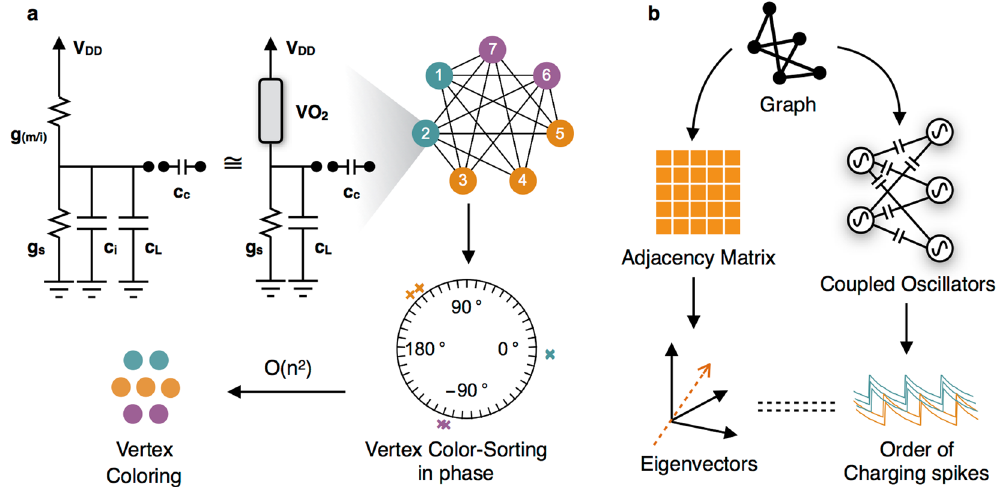
Figure 1. Overview of the circuit and system dynamics. ( a ) Overview of the proposed system for vertex coloring and a simulation example. First step is a coupled relaxation oscillator circuit where the oscillators are composed of a series combination of VO 2 device and a resistor (with a loading capacitor in parallel), and are connected in a graph using capacitors. The equivalent circuit diagram of the VO 2 oscillator is shown using an internal capacitance c i and a phase changing conductance g ( m / i ) which switches between metallic conductance g m and insulating conductance g i . An example 3-partite graph is simulated and the relative phases of these oscillators are shown in a phase diagram which shows vertex color-sorting in phase, and can be used to calculate vertex-coloring with O(n 2 ) complexity. ( b ) The circuit is composed of VO 2 oscillators capacitively coupled in a network same as the input graph. The final order of phases, or charging spikes, of the oscillators is related to the eigenvectors of the adjacency matrix of the input graph which in turn are related to the solution of the graph coloring